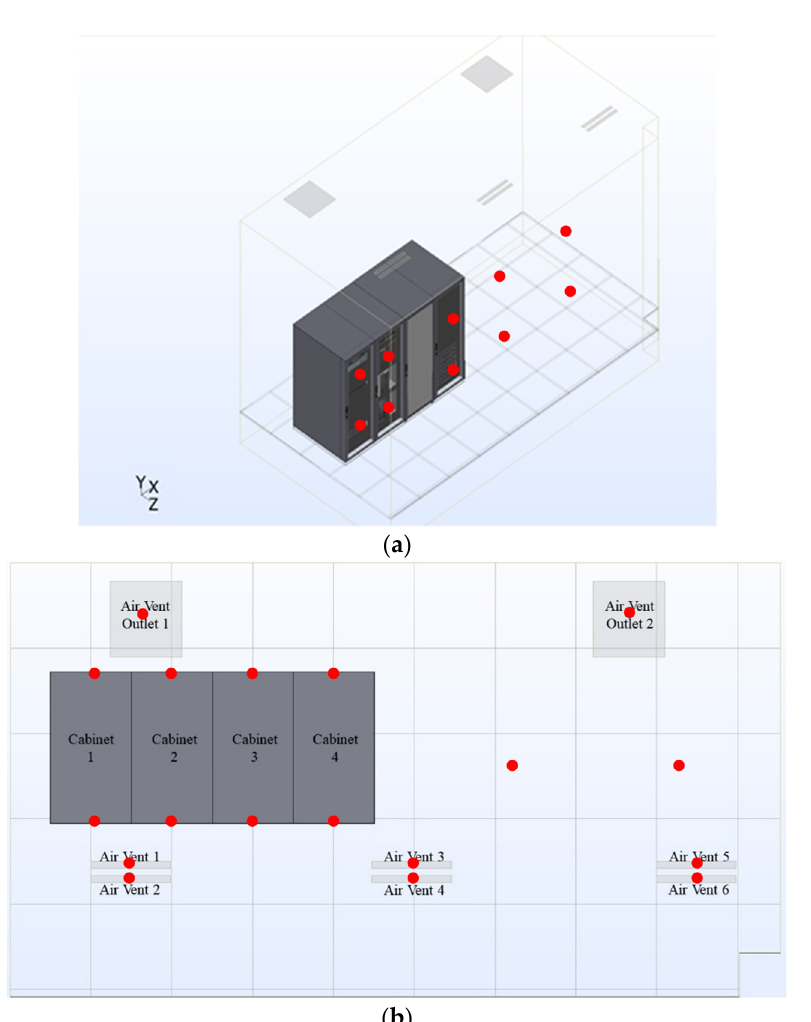
Figure 1. Baseline model of the data center room ( a ) isometric view ( b ) top view.